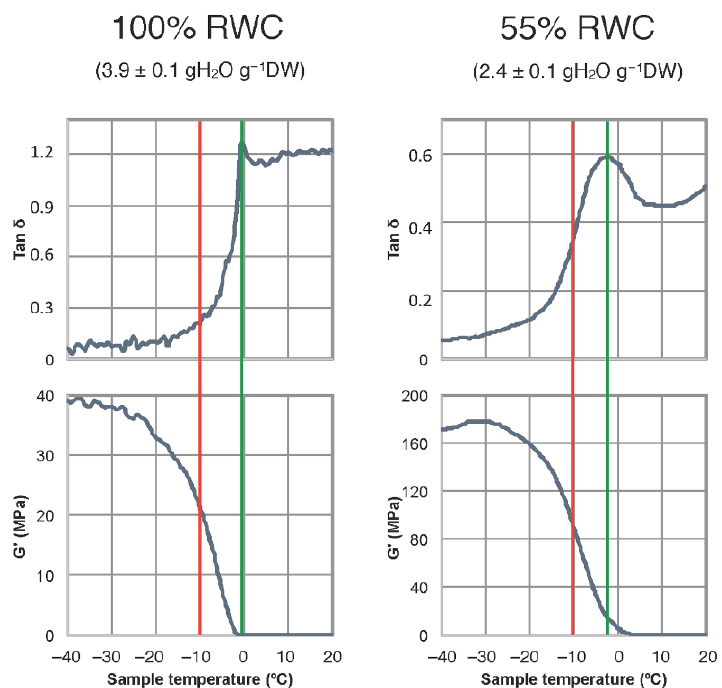
Figure 1. Dynamic mechanical thermal analysis (DMTA) scans of Haberlea rhodopensis leaves (dark grey line) at full turgor (100% RWC, ( left )) or partially dehydrated (55% RWC, ( right )). The green line highlights the glass transition temperature (Tg), which is identified as a peak in the Tan δ (upper panels). The Red line represents a putative winter temperature in H. rhodopensis natural environment. One representative curve from two independent biological replicates is shown for each hydration state.